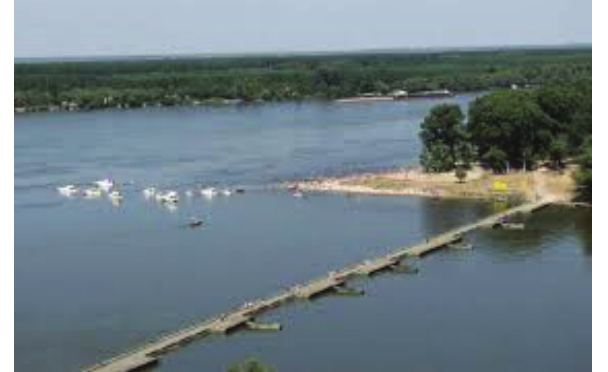
Figure 3 – Pontoon bridge class 20 Рис . 3 – Понтонный мост класс 20 Слика 3 – Понтонски мост класе